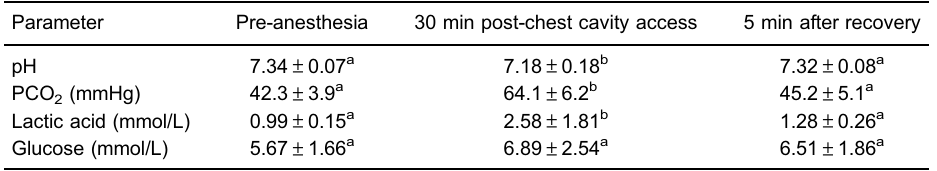
Table 3. Comparison of arterial blood gas values between different time